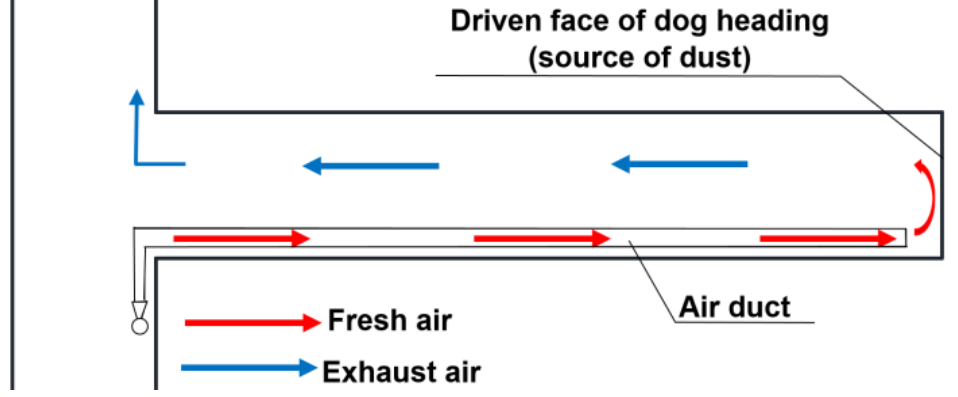
Figure 1. Ventilation diagram for a driven dog heading.